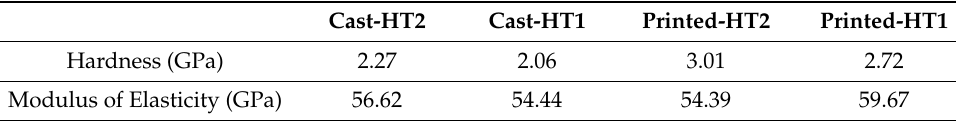
Table 4. Hardness and modulus of elasticity values.